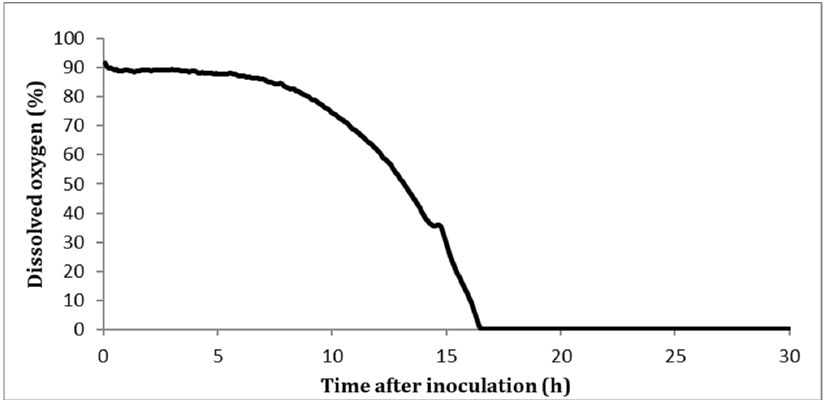
Figure 2. Decreased response of dissolved oxygen (0.2% air saturation) after fungal inoculation in 2 L bioreactor using 1.3 L working volume of PDB at 25 °C, with an aeration rate of 190 mL/min (90% initial air saturation) and stirring at 30 rpm.